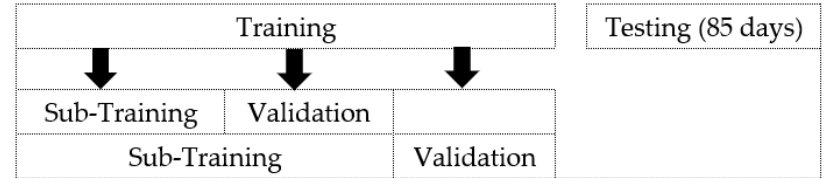
Figure 1. 2-fold time series cross validation. Table 3. Hyperparameters of estimators.